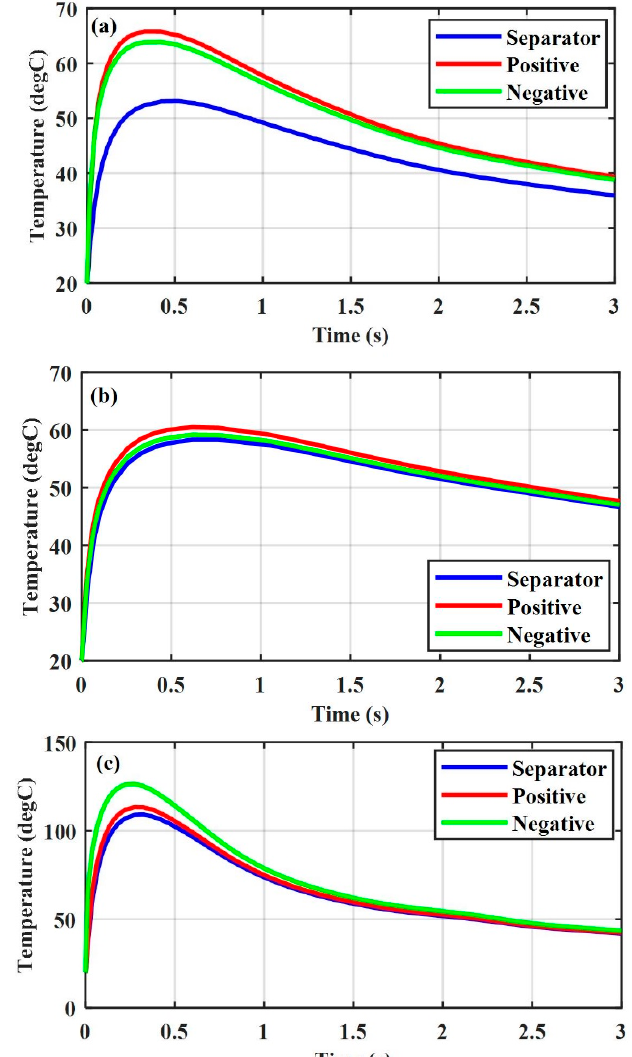
Figure 2. Thermal responses of various ISC conditions for a Li-ion battery at SOC = 0.2 and r in = 0.5 mm. ( a ) Positive–negative, ( b ) copper-positive, and ( c ) aluminum-negative.